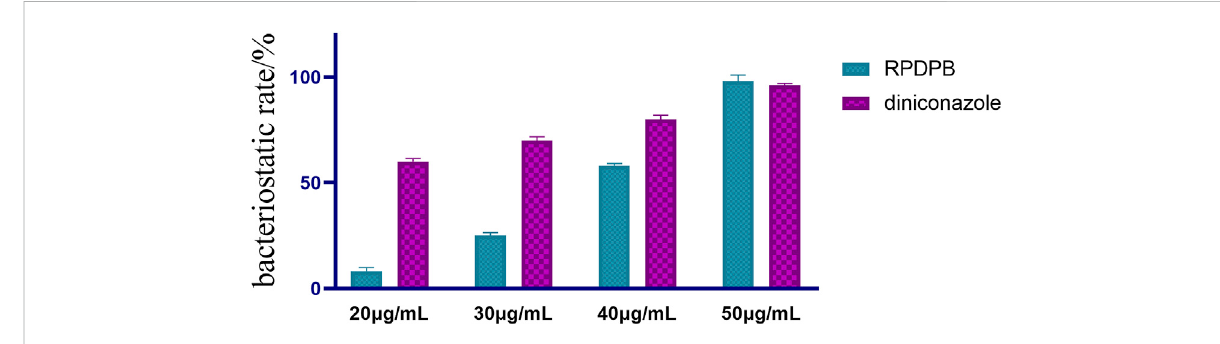
FIGURE 4 Comparison of inhibitory activities of RPDFB and diniconazole against- Gibberella zeae